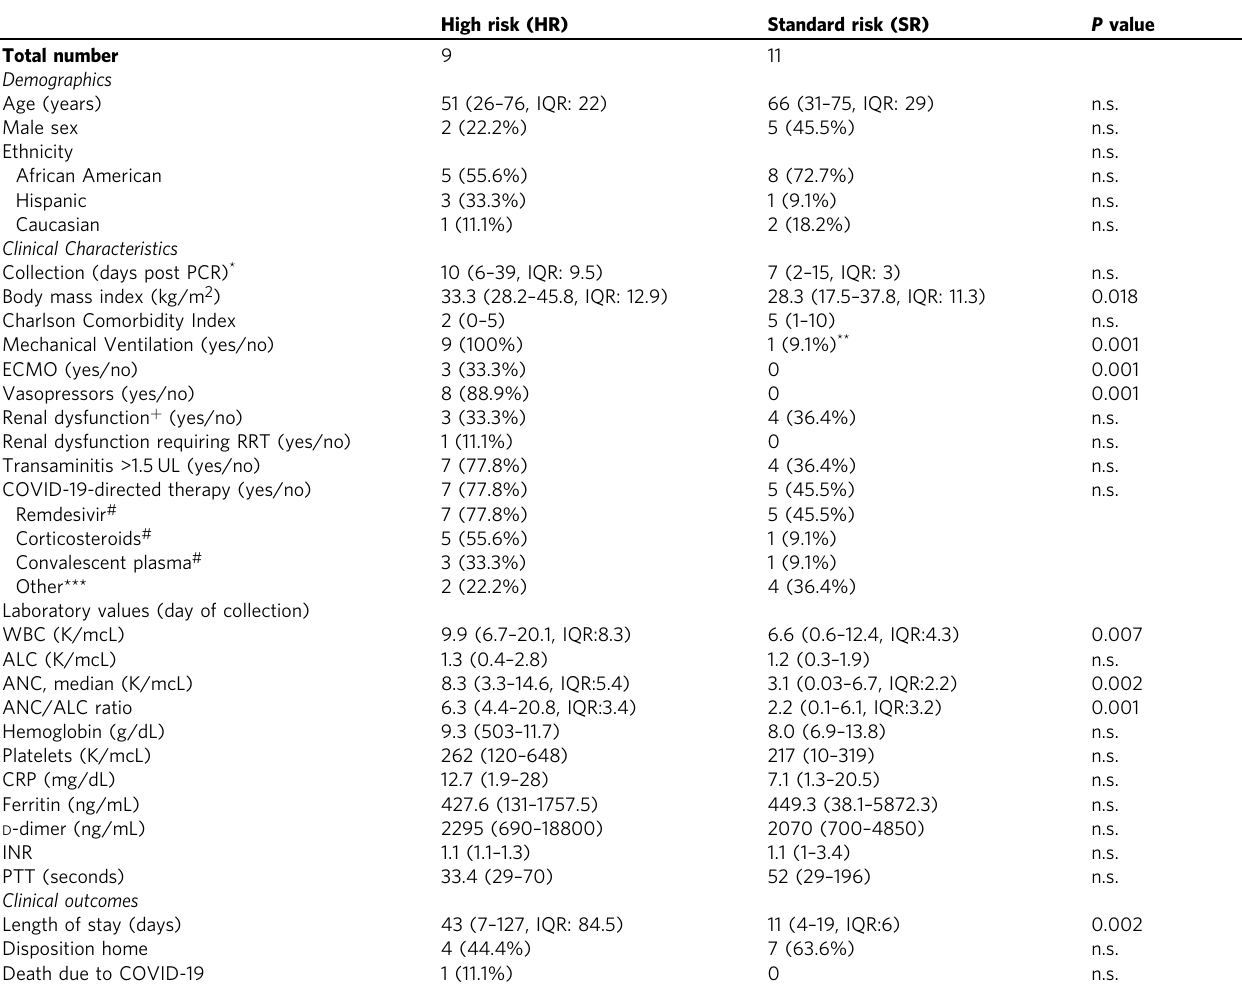
Table 1 Patient